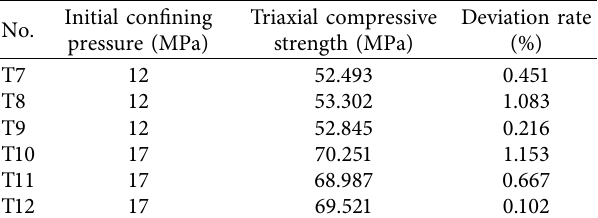
Table 5: Verification of experimental